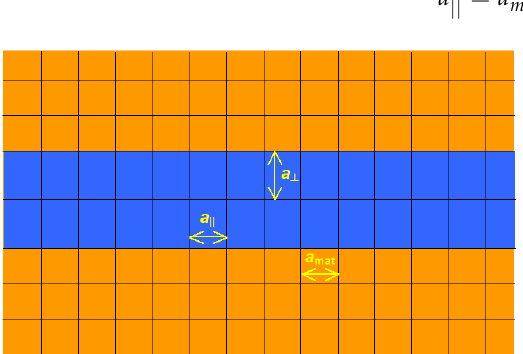
Figure 5. Thin layer of the material with a high lattice constant coherently strained to the matrix of a material with a low lattice constant. material with a low lattice